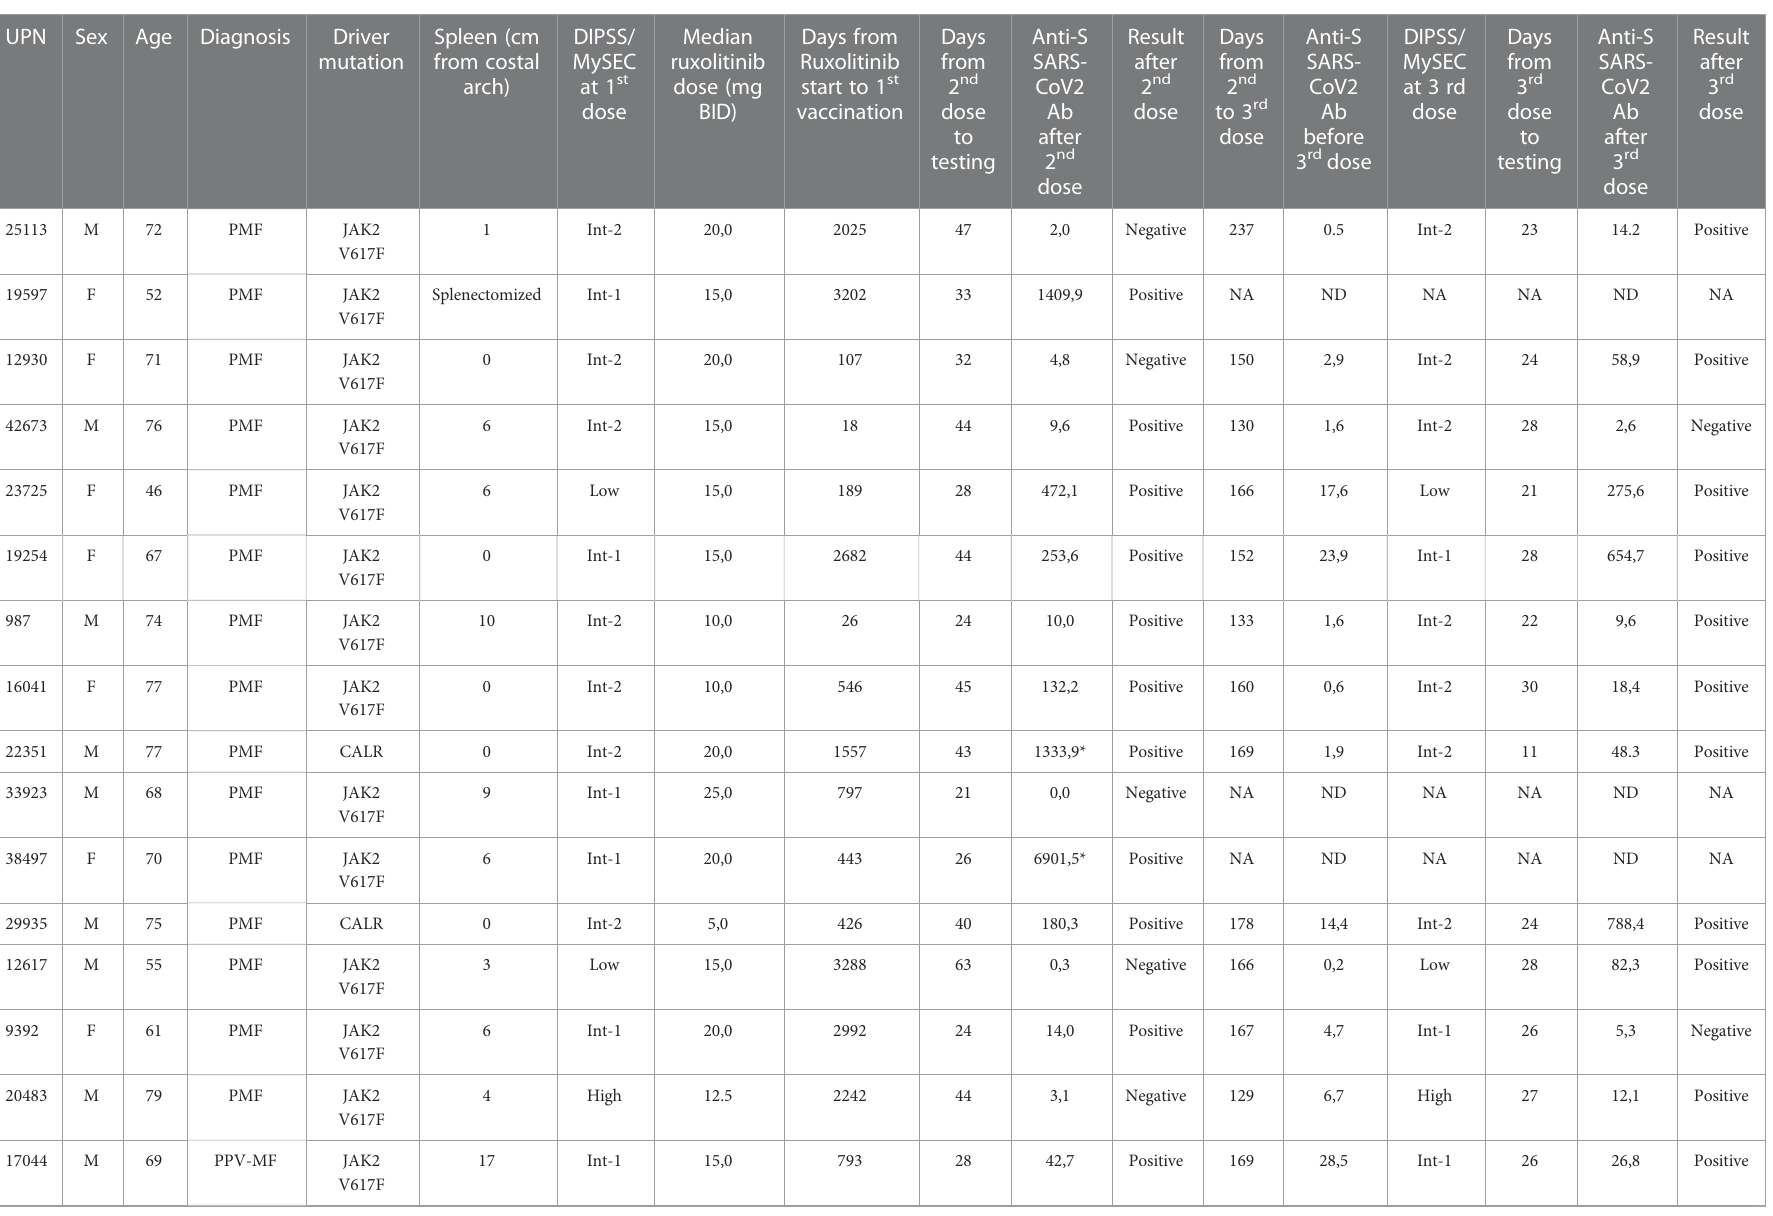
TABLE 1 Antibody level against SARS-CoV-2 N- and S-proteins in myelo fi brosis patients.